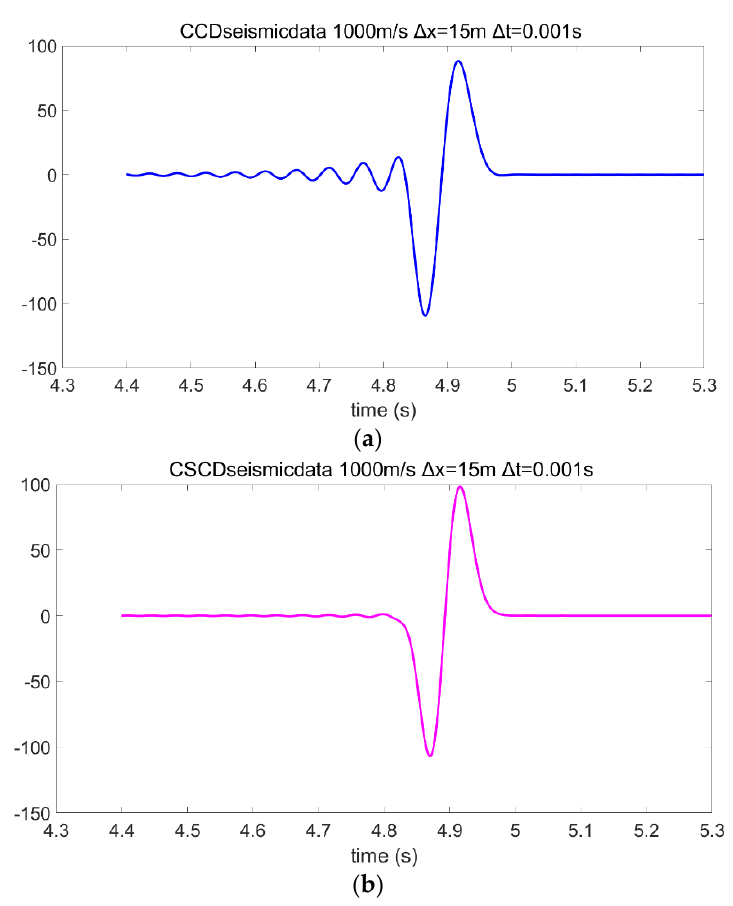
Figure 5. ( a ) CCD is used to simulate the numerical simulation of seismic records in the 1D homo ‐ geneous medium model, Δ x = 15 m; ( b ) CSCD is used to simulate the numerical simulation of neous medium model, ∆ x = 15 m; ( b ) CSCD is used to simulate the numerical simulation of seismic seismic records in the 1D homogeneous medium model, Δ x = 15 m. records in the 1D homogeneous medium model, ∆ x = 15